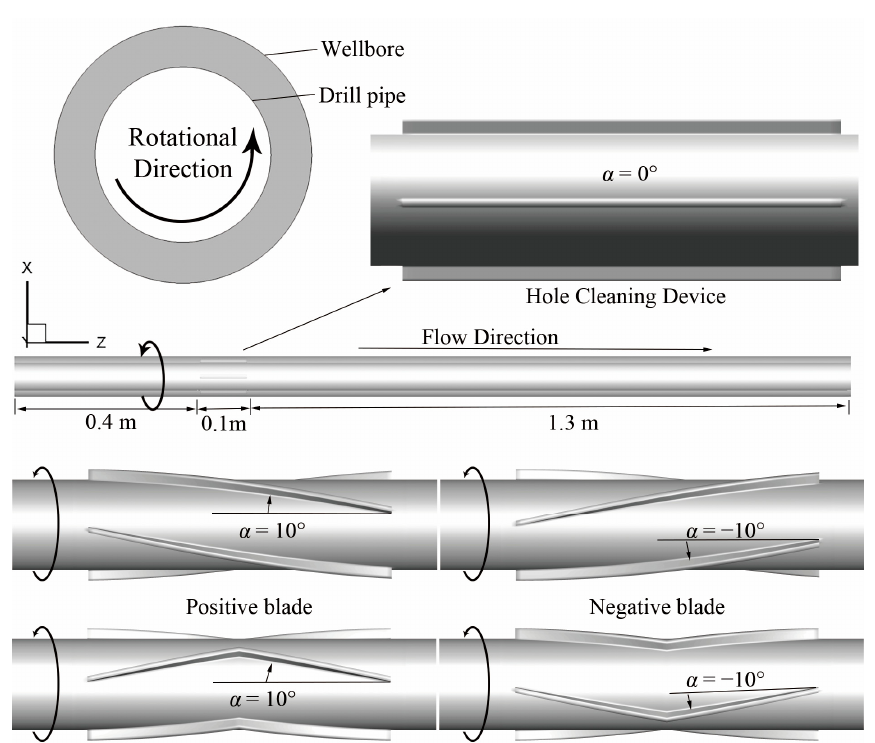
Figure 1. Schematic of selected design parameters for the straight blade and V-shaped blade of the hole cleaning device geometry.